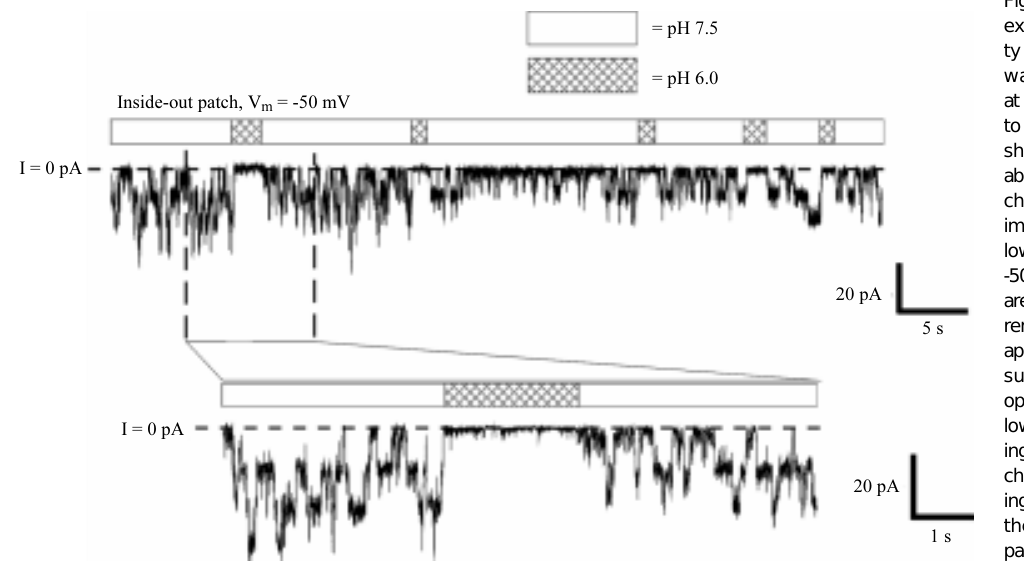
Figure 4 - Cx46 hemichannels in excised patches show sensitivi- ty to pH. An inside-out patch was placed in a solution stream at pH 7.5 and rapidly switched to the same solution at 6.0. A sharp decrease in the open prob- ability of the four active hemi- channels in the patch is seen immediately upon switching to low pH. Holding potential